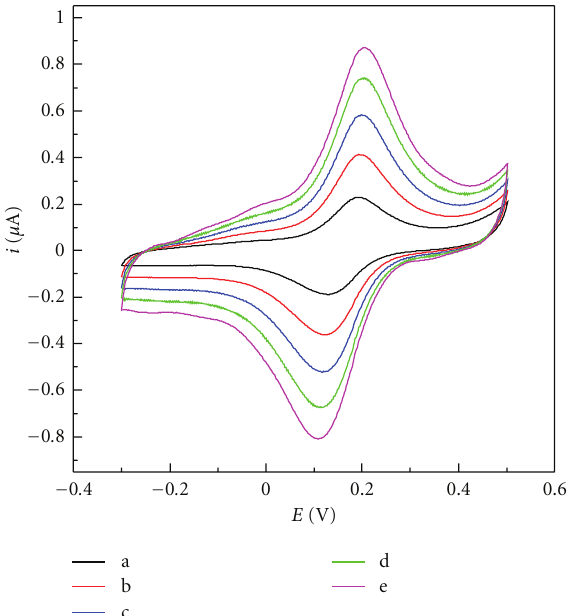
Figure 6: CV recorded on a PEDOT/LS-modified electrode in phosphate bu ff er (pH 7.4) at sweep rates of 10 (a), 20 (b), 30 (c), 40 (d), and 50 mVs − 1 (e), respectively.